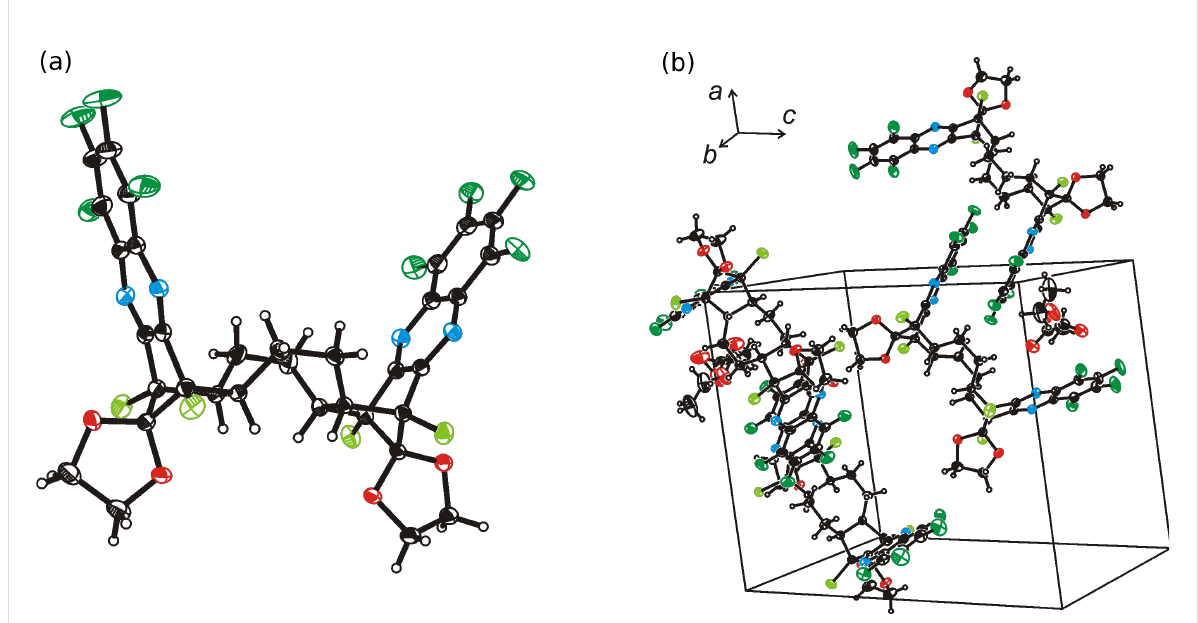
Figure 1: (a) Thermal ellipsoid image of the tweezer molecular 16c in the structure 16c · CH 3 CO 2 C 2 H 5 ; thermal ellipsoids are drawn at the 50% prob- ability level. (b) View of the packing of 16c in the unit cell (two CH 3 CO 2 C 2 H 5 molecules are omitted for clarity). [C 34 H 20 Cl 4 F 8 N 4 O 4 · CH 3 CO 2 C 2 H 5 , MW = 930.44, monoclinic, space group P 2 1 / n , a = 15.3990(12) Å, b = 14.0635(11) Å, c = 17.7148(14) Å, β = 94.6470(10)°, V = 3823.8(5) Å 3 , Z = 4, d calc = 1.616 g cm − 3 , T = 153(2) K, λ = 0.71073 Å, 44247 reflections measured, 9378 unique ( R int = 0.017), final R 1 [ I > 2 δ (I) ] = 0.0343 and R 1 = 0.0403 ( wR 2 = 0.0952) for all data; CCDC deposit # 786086.